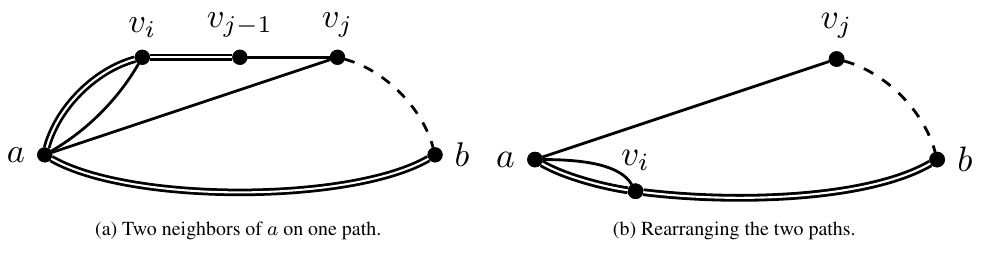
Fig. 6: Distributing neighbors to different paths in the proof of Lemma